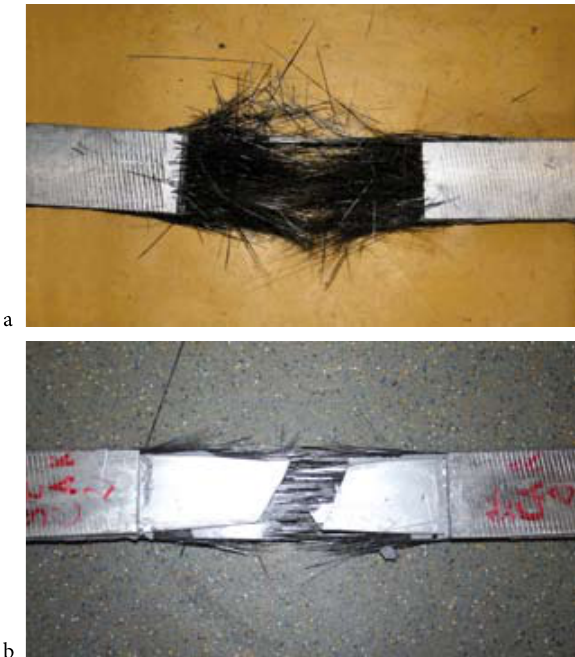
Fig. 3. The types of failure of CFRP and hybrid composite specimens: a – CFRP specimen; b – hybrid composite specimen